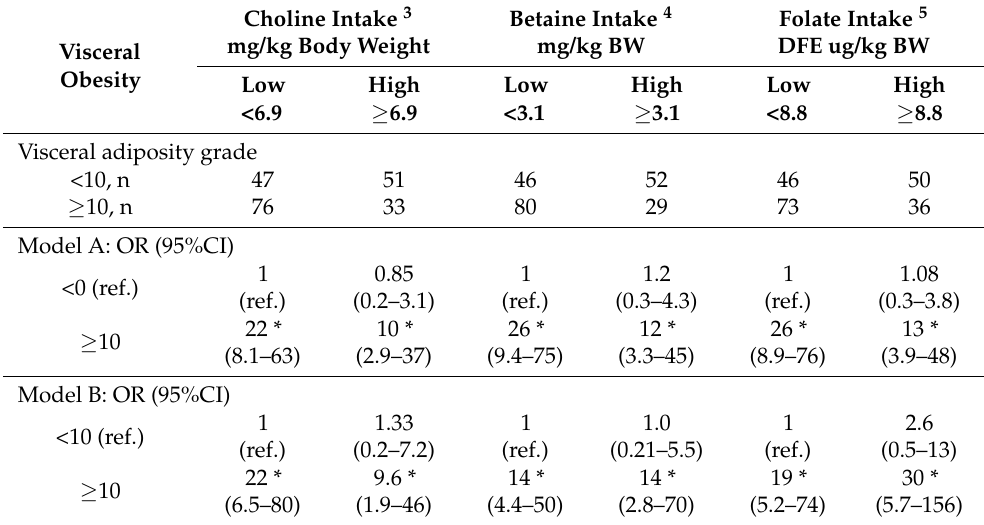
Table 4. Threshold intake of individual MDN associated with VOB-related HS 1,2